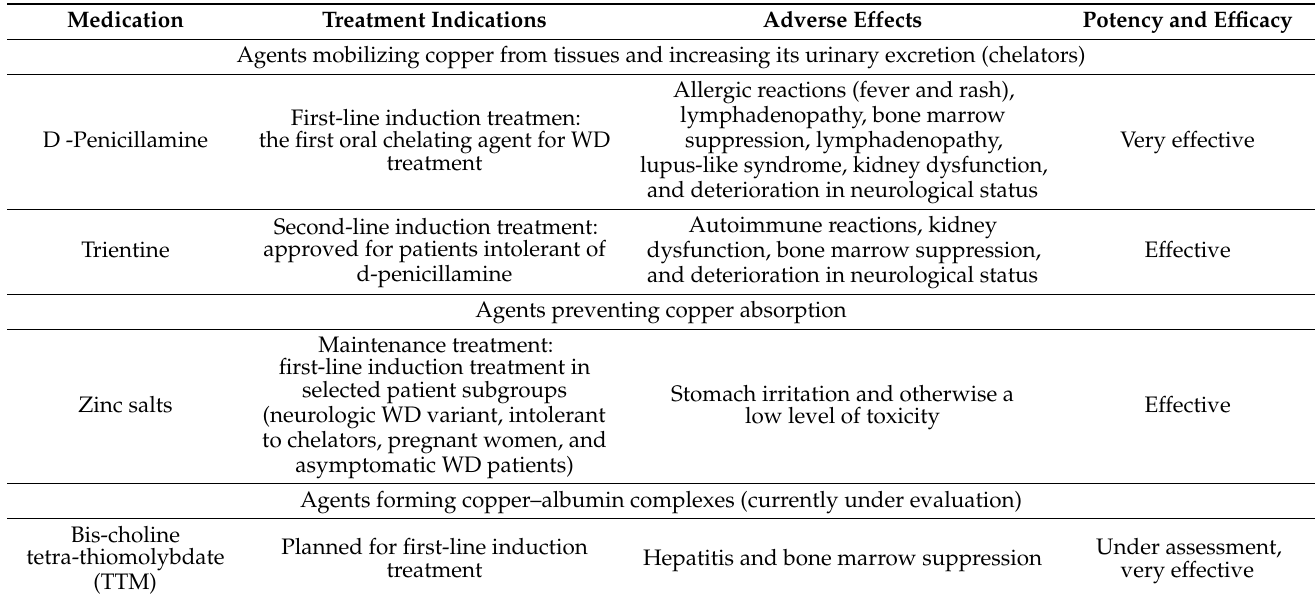
Table 2. Characteristics of medications available for the treatment of Wilson’s disease [45,46,48,72–75].